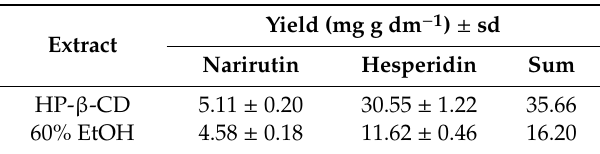
Table 4. Yields of the major WOP polyphenols, achieved with hydroxypropyl- β -cyclodextrin (HP- β -CD) and 60% aqueous ethanol (EtOH), at 40 ◦